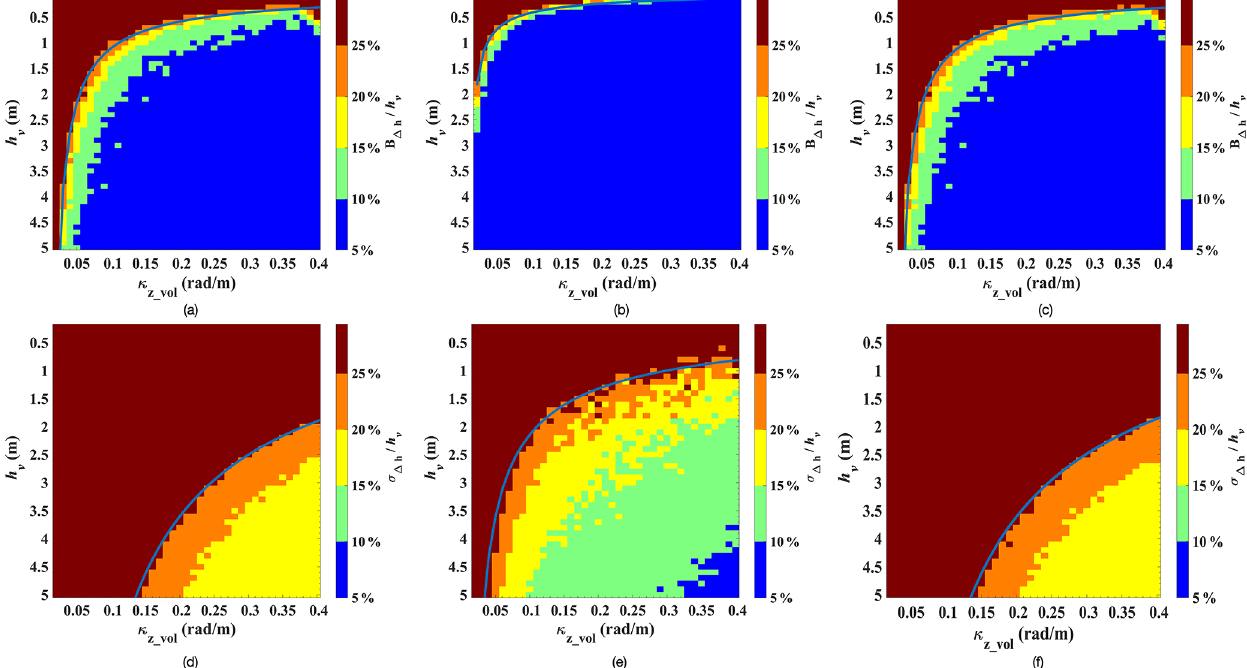
/h v and (d–f) relative standard deviation σ δ Figure 9. (a–c) Relative bias B δ h Fixed parameters: (a–f) σ 1 = 2dBm − 1 , m 1 = 0 . 3, z 1 = − 0 . 15m, and α = 0 . 5; variable parameters: (a, d) σ 2 = 20dBm − 1 , m 2 = 0 . 5, (b, e) σ 2 = 20dBm − 1 , m 2 = 2, and (c, f) σ 2 = 100dBm − 1 , m 2 = 0 . 5. Blue line indicates the threshold of B δ